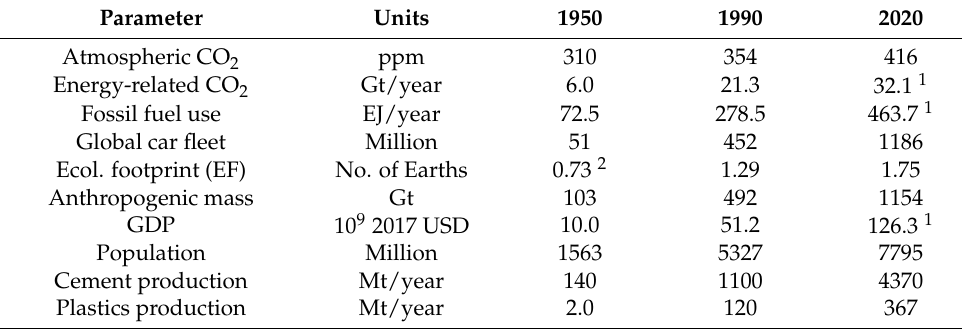
Table 2. Global values for various parameters, 1950, 1990, and